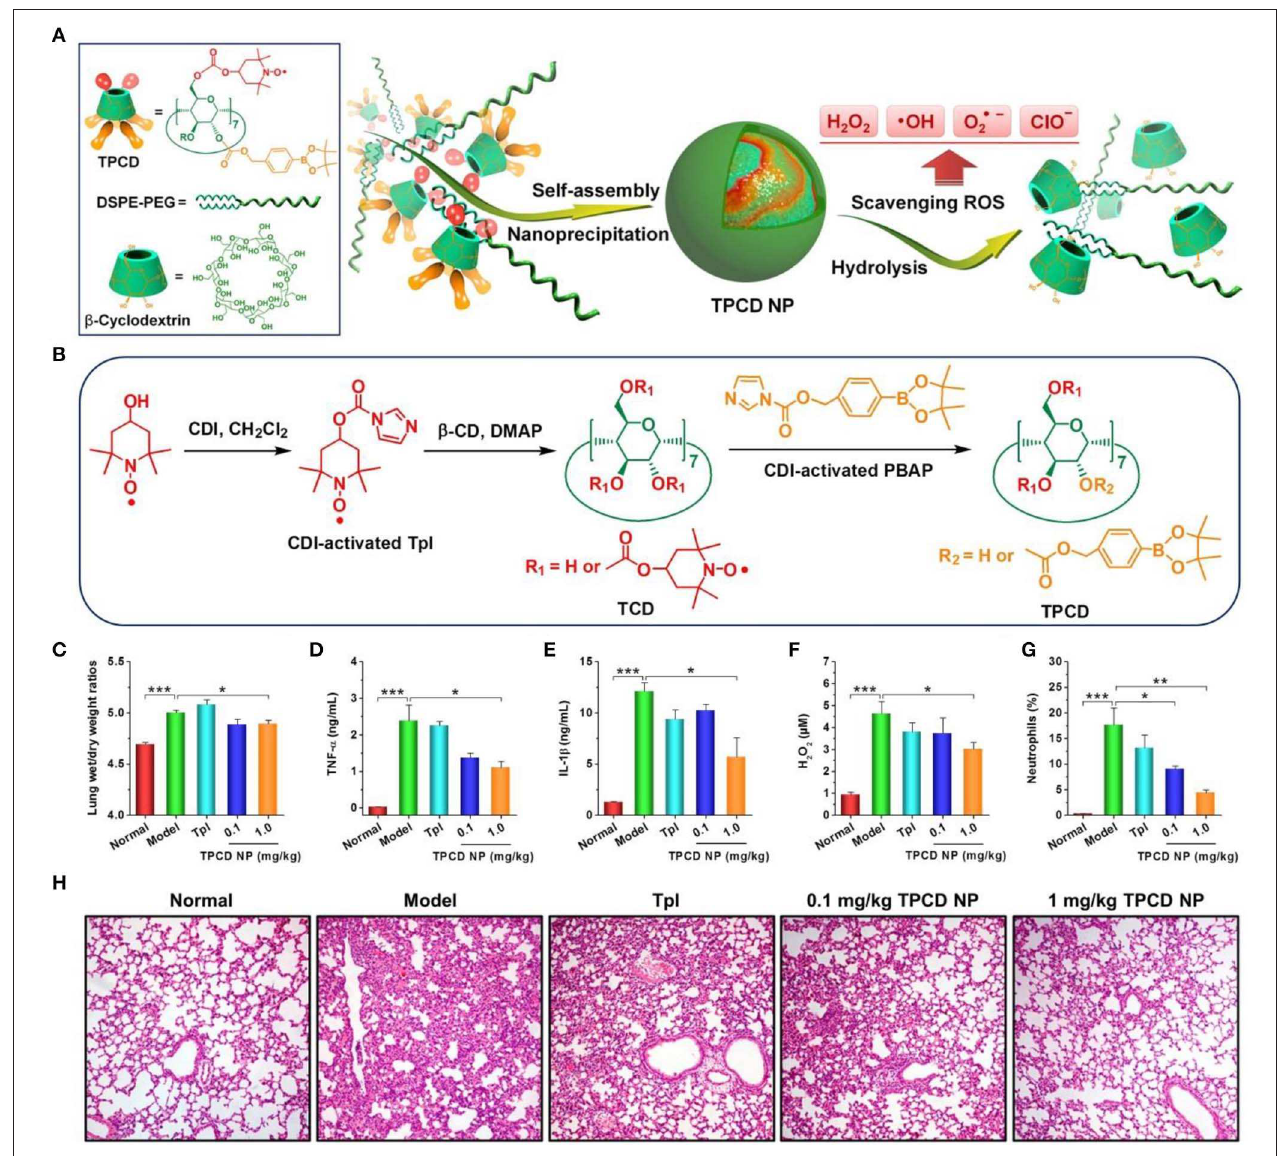
FIGURE 3 | Design and preparation broad-spectrum ROS-scavenging nanoparticles for treatment of acute lung injury (ALI). (A) Schematic illustration of engineering of a broad-spectrum ROS-scavenging material and its nanoparticles based on functionalized β -CD. (B) The synthetic route of β -CD conjugated with Tempol (Tpl) and PBAP units (TPCD). CDI, 1,1-carbonyldiimidazole; DMAP, 4-dimethylaminopyridine; TCD, Tpl-conjugated β -CD; PBAP, 4-(hydroxymethyl) phenylboronic acid pinacol ester. (C–H) Treatment of ALI with TPCD nanoparticles (i.e., TPCD NP) in mice. (C) The lung wet-to-dry weight ratios after different treatments. (D–G) The expression levels of TNF- α (D) , IL-1 β (E) , and H 2 O 2 (F) in bronchoalveolar lavage fluid from mice with LPS-induced ALI and subjected to different treatments. (G) Quantified neutrophil counts in pulmonary tissues of ALI mice. (H) H&E-stained pathological sections of lung tissues. Data are mean ± standard error ( n = 6). * P < 0.05, ** P